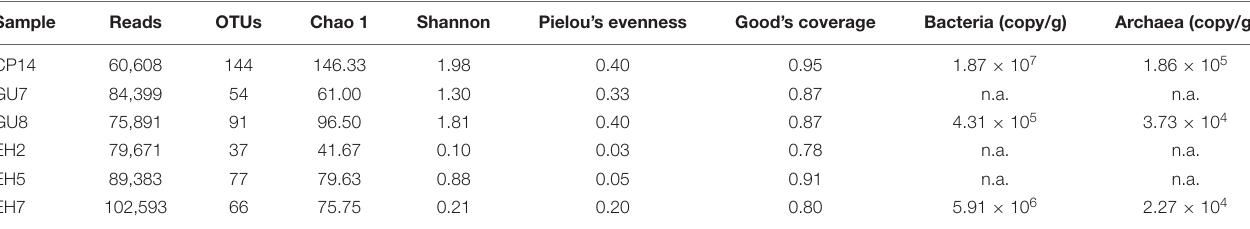
TABLE 2 | Biodiversity indicies of bacterial communities and16S rRNA gene copies from the Union Glacier area.